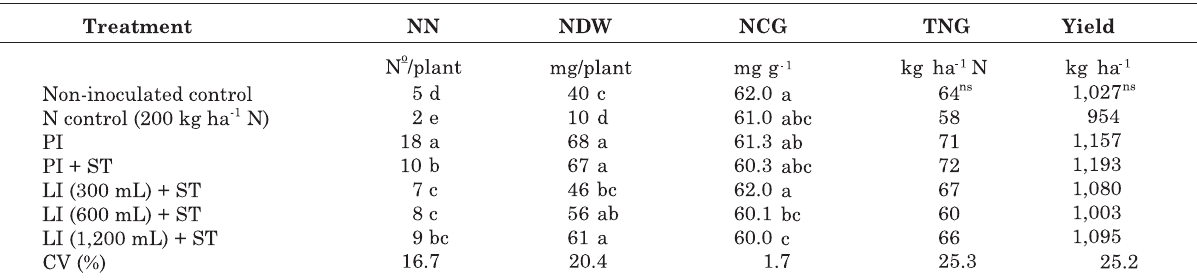
Table 7. Nodule number (NN) and dry weight (NDW) at the V4 stage, N grain content (NGC), total N grain content (TNG), and grain yield at harvest of soybean inoculated with peat (PI) or liquid (LI) inoculant, with or without with fungicides and micronutrients (1) seed treatment (ST). Experiment conducted in Jaciara, Mato Grosso, in the 2001/2002 growing season, in a soil treated with inoculant for the first time (<10 2 cells g -1 of soil)